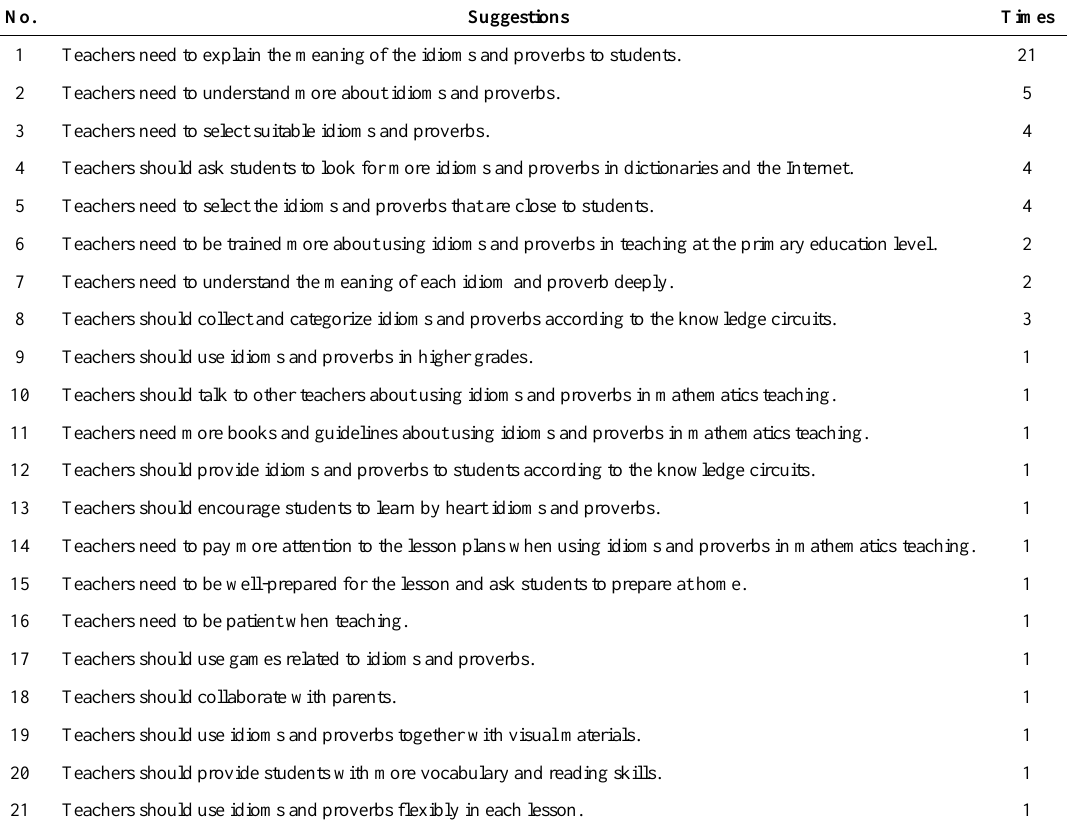
Table 8. Teachers' suggestions for the effectiveness of using idioms and proverbs in mathematics teaching